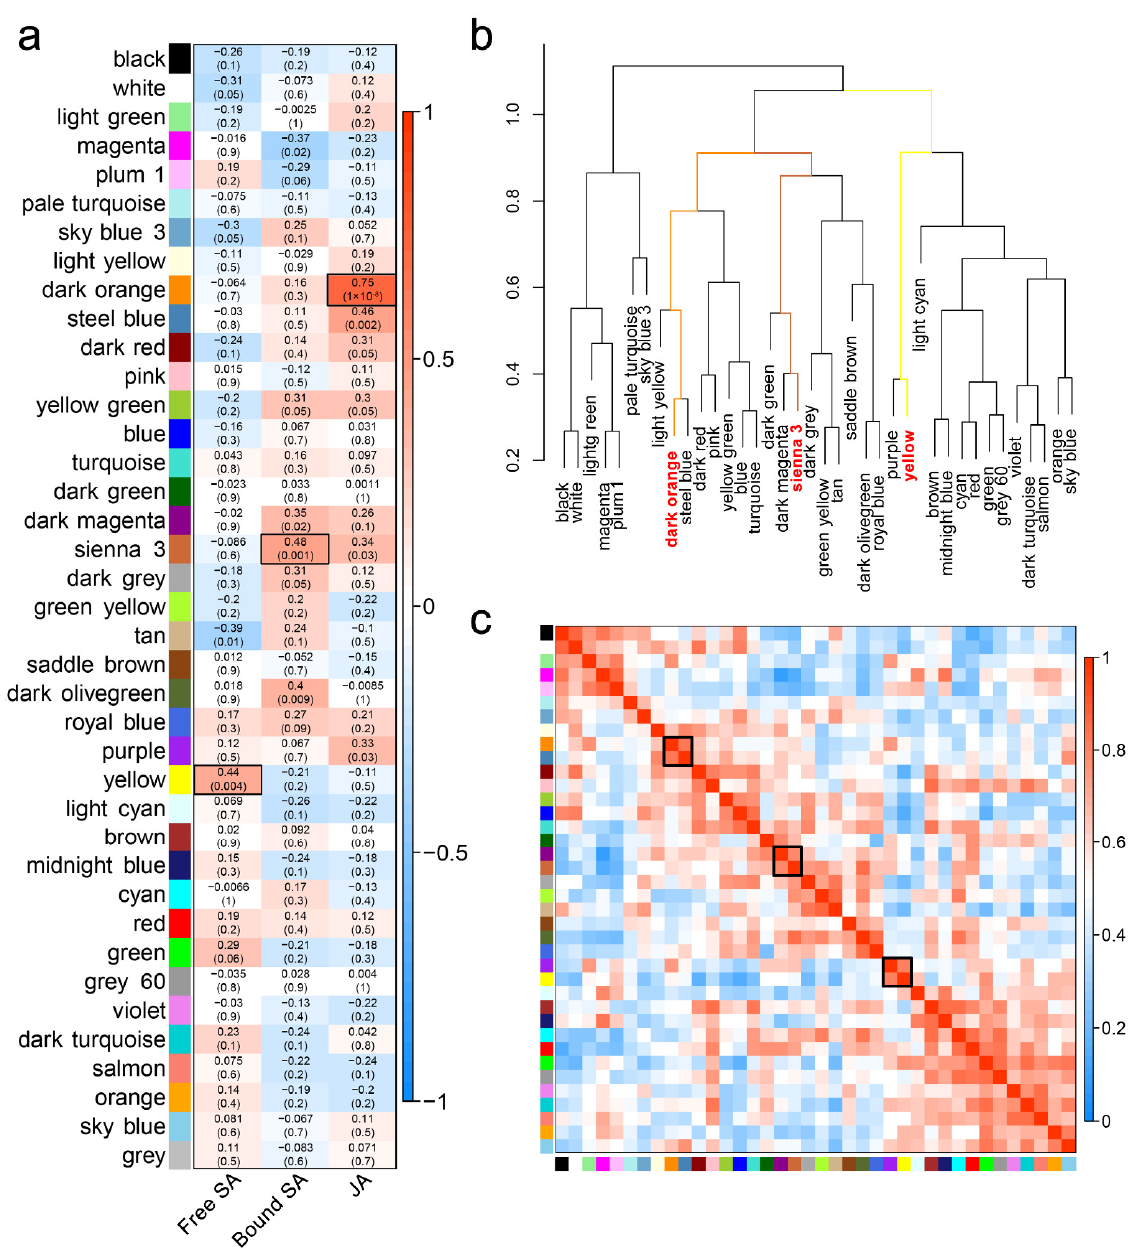
Figure 2. WGCNA revealed the modules highly related to JA or SA. ( a ) Module-trait associations. Each row corresponds to an ME, and each column corresponds to a trait. Each cell contains the corresponding correlation and p -value. The table is colour-coded by correlation according to the colour legend. ( b ) The hierarchical clustering dendrogram of correlated MEs. ( c ) The heatmap of correlated MEs.